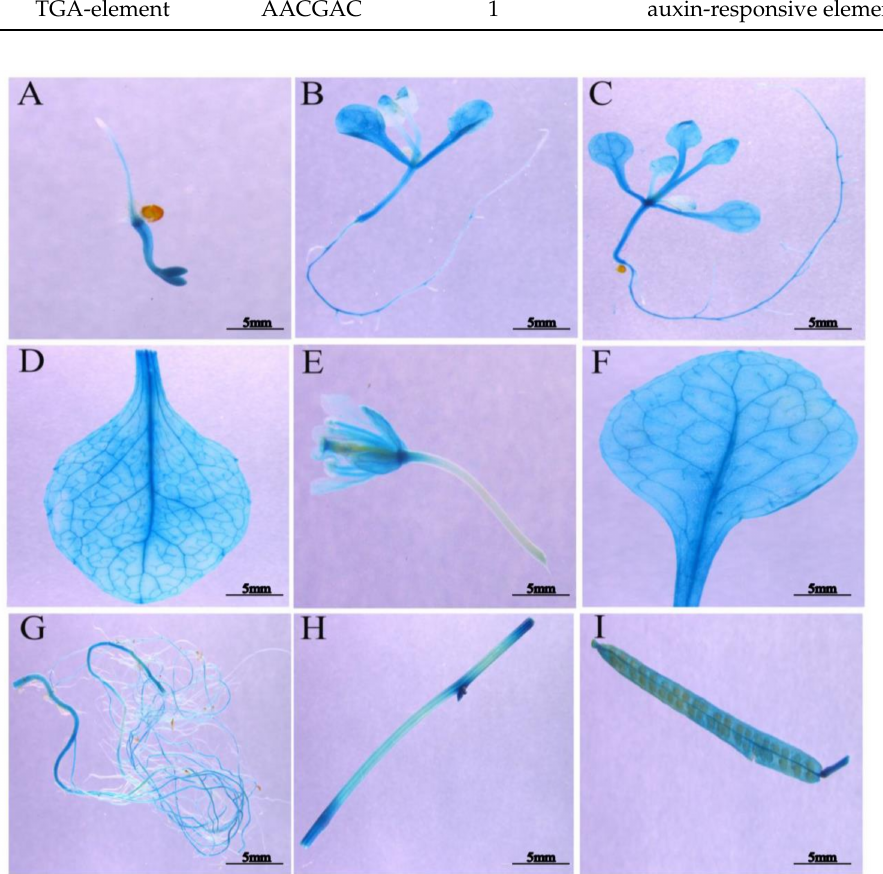
Figure 2. Temporal and spatial expression patterns of SmSPL6 . ( A ) Two days after germination. ( B ) Seven days after germination. ( C ) Ten days after germination. ( D ) Rosette leaf. ( E ) Flower. ( F ) Stem leaf. ( G ) Root at the flowering stage. ( H ) Stem. ( I )